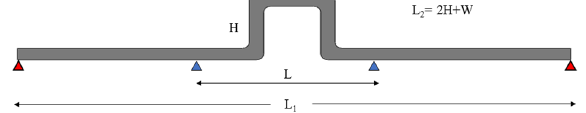
Table 1: Parameters of expansion loop pipe at 16, 20, 24-inches pipe diameters.